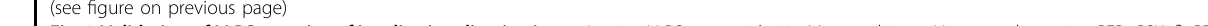
Fig. 2 Validation of LLPS proteins of insulin signaling in vitro. a In vitro LLPS assay with 20 μ M recombinant His-tagged proteins GFP, GSK3 β -GFP, PRAS40-GFP, BAD-GFP, and P27-GFP with or without 3% PEG8000. Scale bar, 10 μ m. b In vitro LLPS assay with recombinant His-tagged full-length IRS1-GFP with 3% PEG8000± NaCl. Scale bar, 10 μ m. c Schematic illustration of domains and fragments of mouse IRS1. Eight tyrosine sites regulated by insulin receptor are shown in the diagram. d In vitro LLPS assay with recombinant His-tagged four fragments IRS1-GFP with 3% PEG8000. Scale bar, 10 μ m. e Fusion of droplets of His-tagged IRS1 N243-S600 -GFP. Red arrows showed the two droplets that fused during the experimental period. Time Zero started at 90 s after the addition of PEG8000. Scale bar, 10 μ